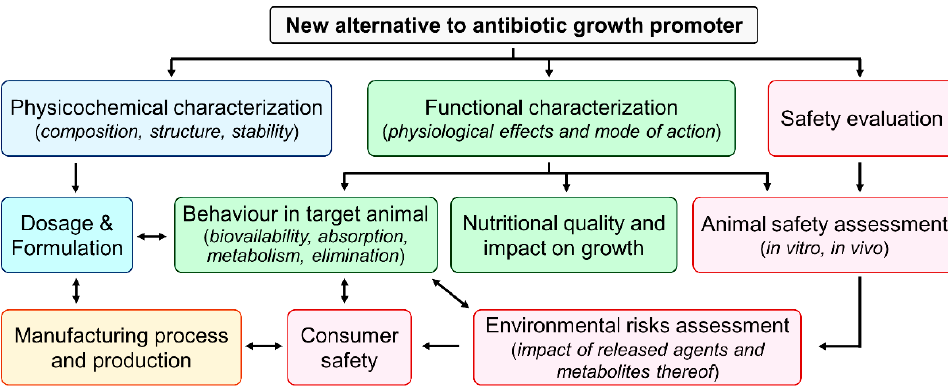
Figure 4. Important parameters to assess for alternatives to antibiotic growth protomers mixed with feed ingredients before large-scale use.